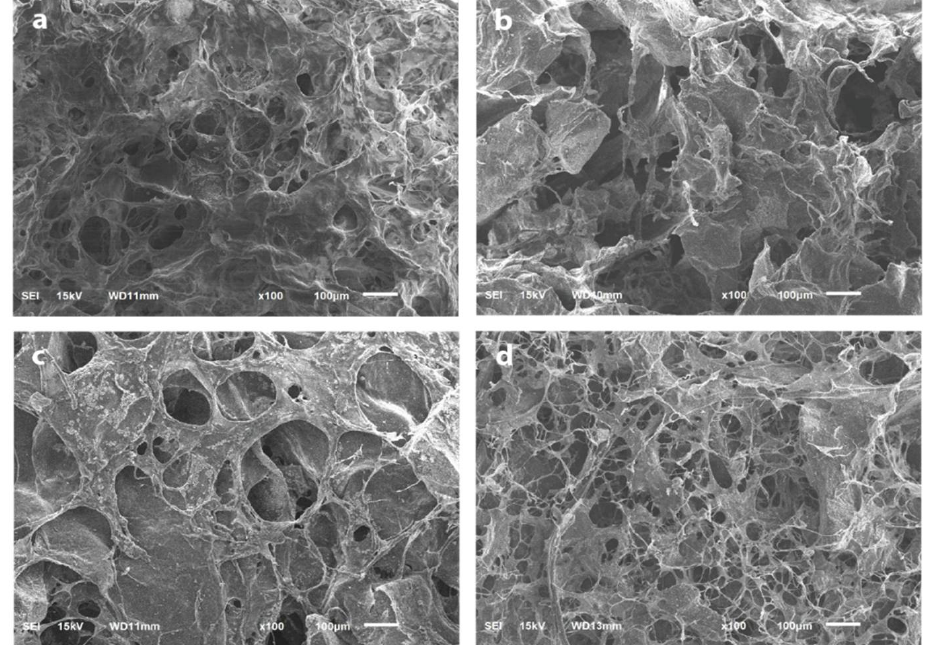
Figure 3. Graph of XRD analysis of all types of bio-composite and modified BAM.